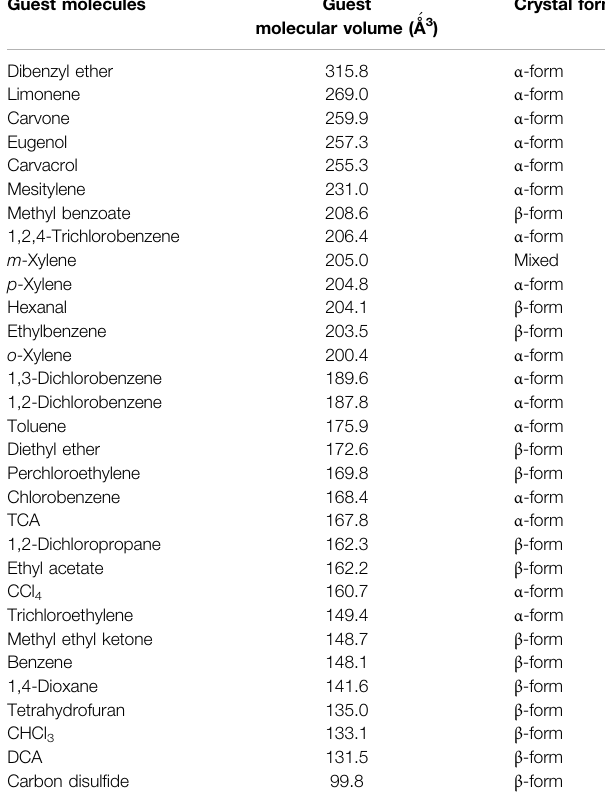
TABLE 2 | Guest molecular volume vs corresponding crystalline